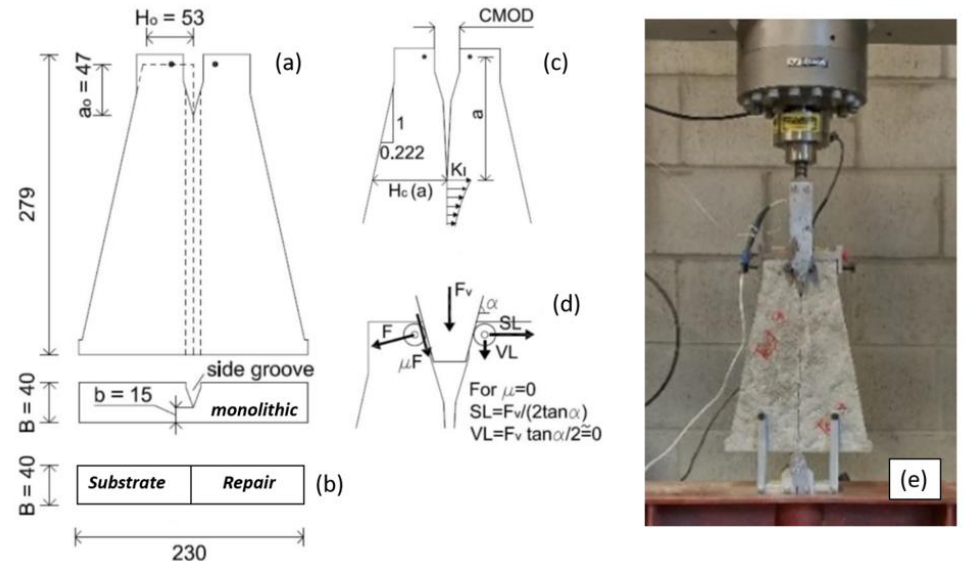
Figure 1. ( a ) Countered double cantilever beam (CDCB) specimen geometry and ( b ) adaptation for testing of bi-material systems, ( c ) parameters for crack growth resistance analysis, ( d ) calculation of forces applied, and ( e ) test setup [15].